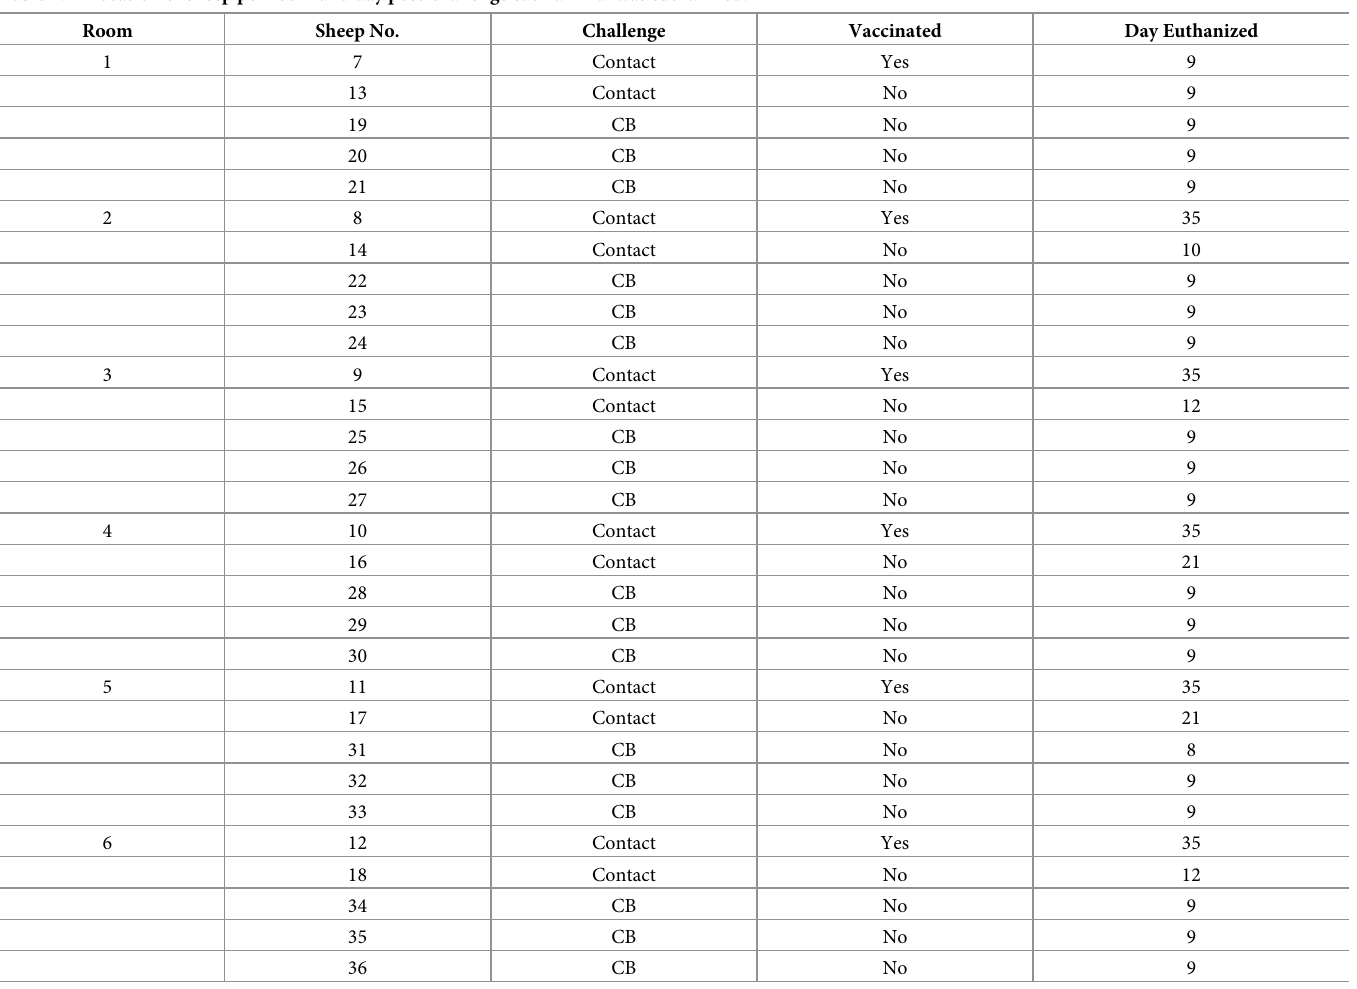
Table 1. Allocation of sheep per room and day post-challenge each animal was euthanized. Room Sheep